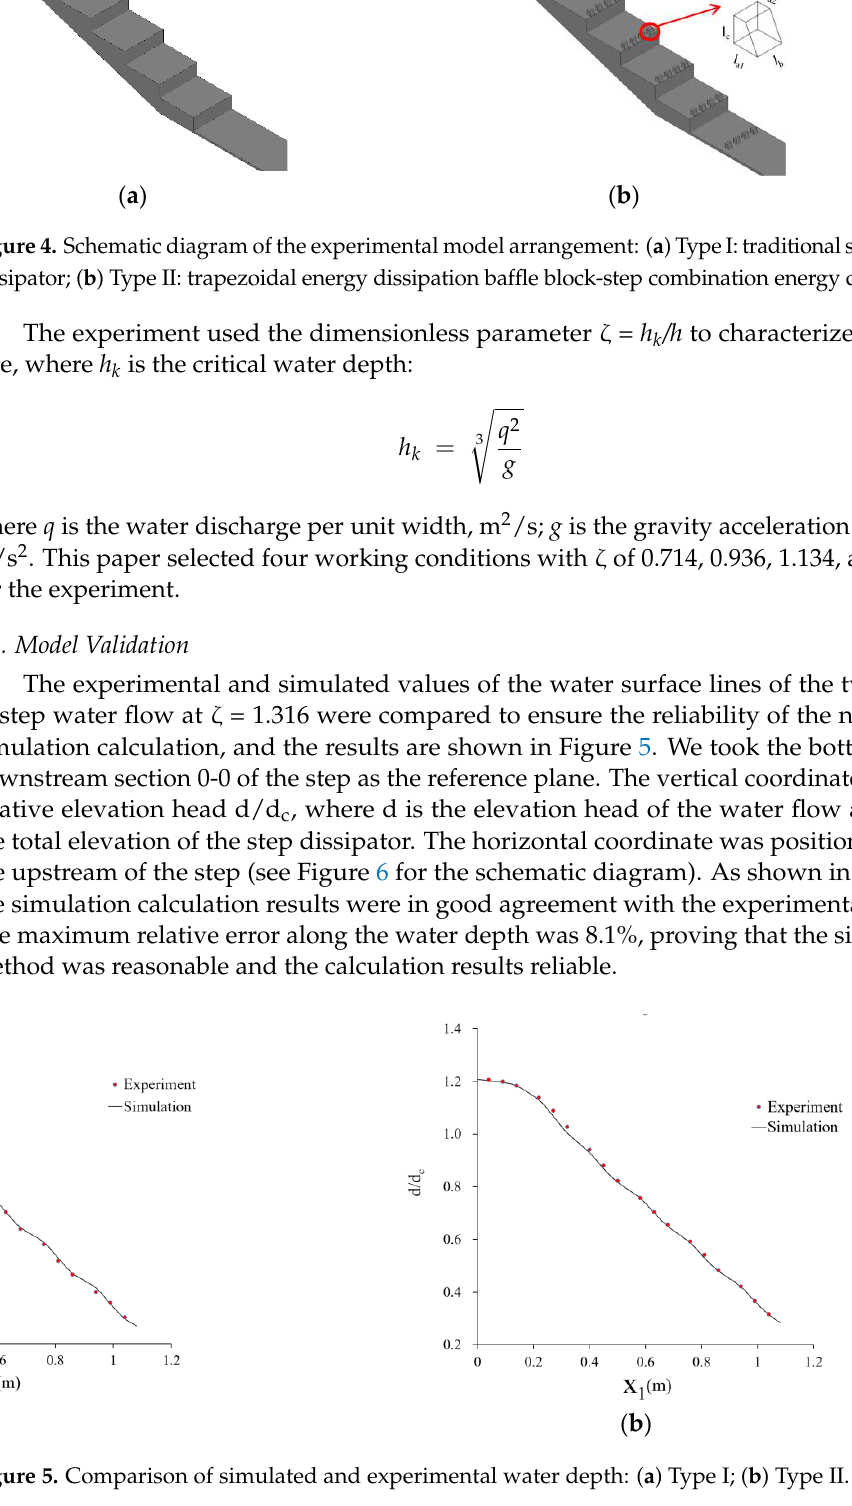
Figure 3. Model experimental setup and profile arrangement: ( a ) experimental model; ( b ) experi- mental model layout section.